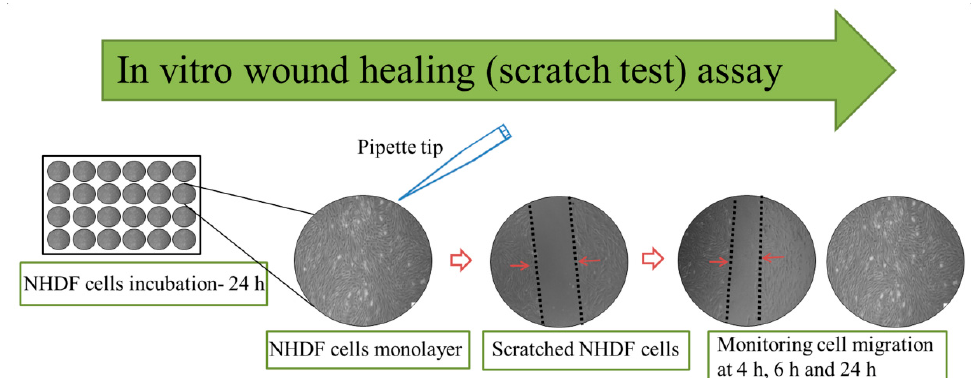
Figure 1. Schematic illustration of in vitro wound healing assay (scratch test) set-up for the study. NHDF: normal human dermal fibroblast. NHDF: normal human dermal